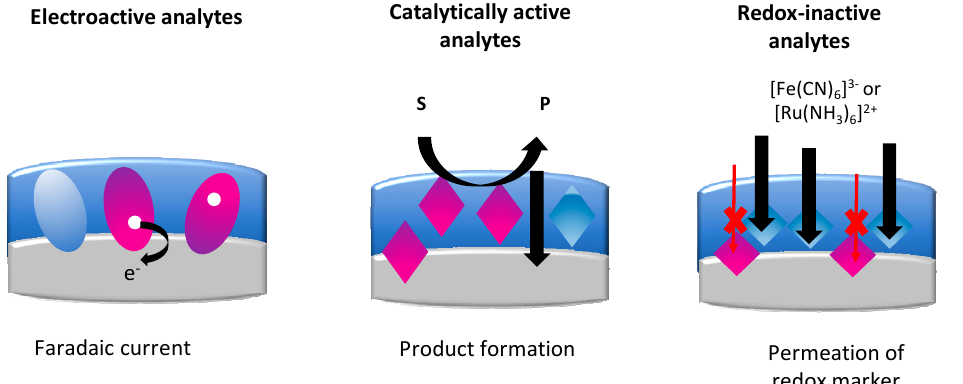
Figure 2. The main approaches used in electrochemical readouts of MIP-based sensors.